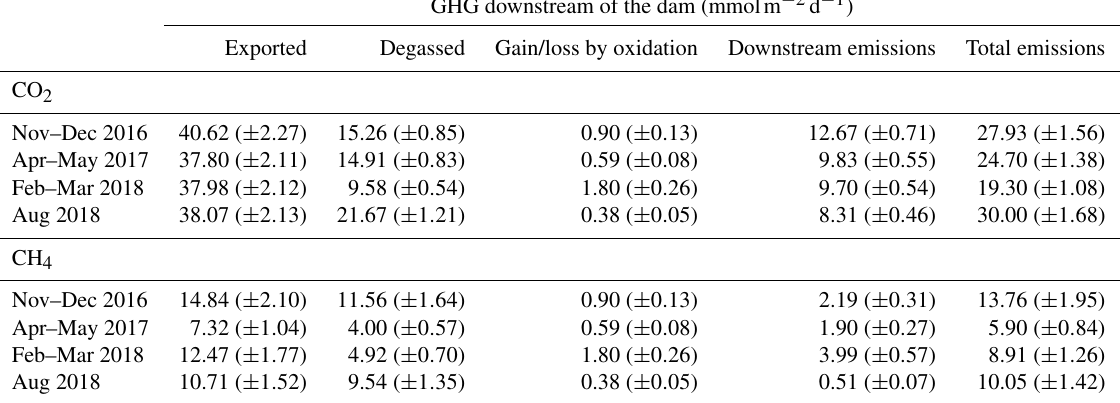
Table 1. CO 2 and CH 4 dynamics downstream of the dam: gas export rate from upstream to downstream of the dam, degassing, result of CH 4 oxidation (CO 2 production and CH 4 consumption), downstream emissions, and total emissions to the atmosphere below the dam. Uncertainties based on variation coefficients are reported in parentheses. Units are in mmolm − 2 d − 1 of reservoir surface